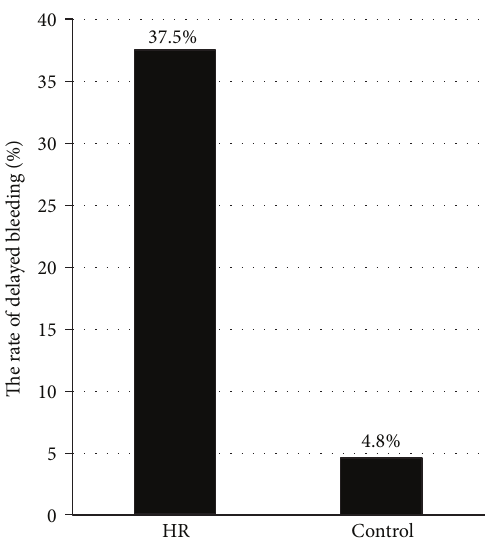
Figure 1: Comparison of the delayed bleeding rate between the ESD under HR group and the control group. Delayed bleeding occurred at a higher frequency in the ESD under HR group than in the control group ( 𝑃 < 0.0001